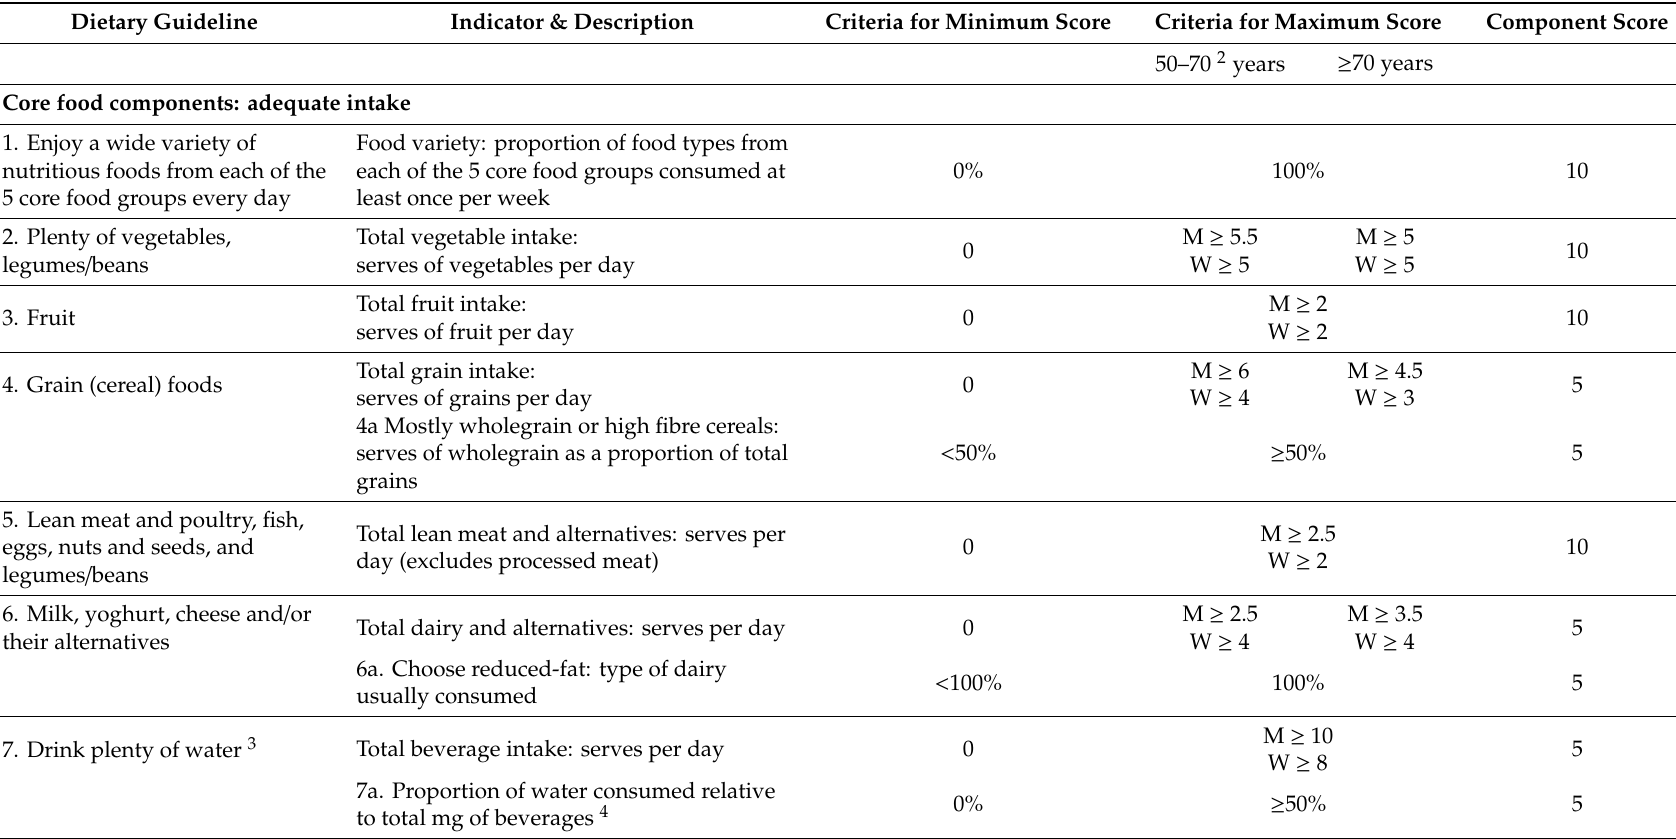
Table 1. Components and scoring approach for the Dietary Guideline Index to measure diet quality in middle-aged to older Australian adults who participated in a dietary intervention trial 1